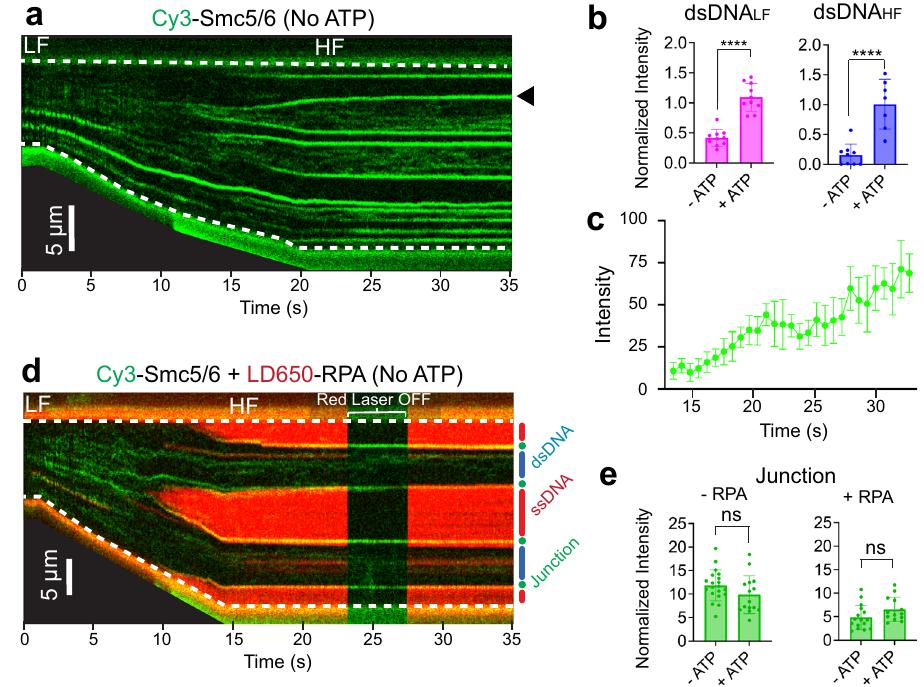
Fig. 2 | Smc5/6 exhibits ATP-dependent binding to dsDNA and ATP- independent binding to junction DNA. a Representative kymograph of a λ DNA tether being stretched from LFto HFinthe presenceof 20nMCy3-Smc5/6(green) withoutATP. b ComparisonofCy3-Smc5/6 fl uorescencesignalsondsDNAbetween − ATPand +ATPconditionsunderLForHF(normalizedbythe numberofpixelsfor each region). Bar heights indicate the group mean and error bars represent stan- dard deviation. P values were determined from two-tailed unpaired t -tests (**** P <0.0001). Sample sizes are: dsDNA LF − ATP ( n =10); dsDNA LF +ATP ( n =10); dsDNA HF − ATP( n =9);anddsDNA HF +ATP ( n =7),where n indicatesthenumberof regions analyzed. c Quanti fi cation of the Smc5/6 fl uorescence signals at a junction DNA site (marked by the black arrow in panel a ) over time in the absence of ATP. Data points indicate the averaged photon count per frame ( n =10 frames) at the junction DNA site and error bars represent standard deviation. d Representative